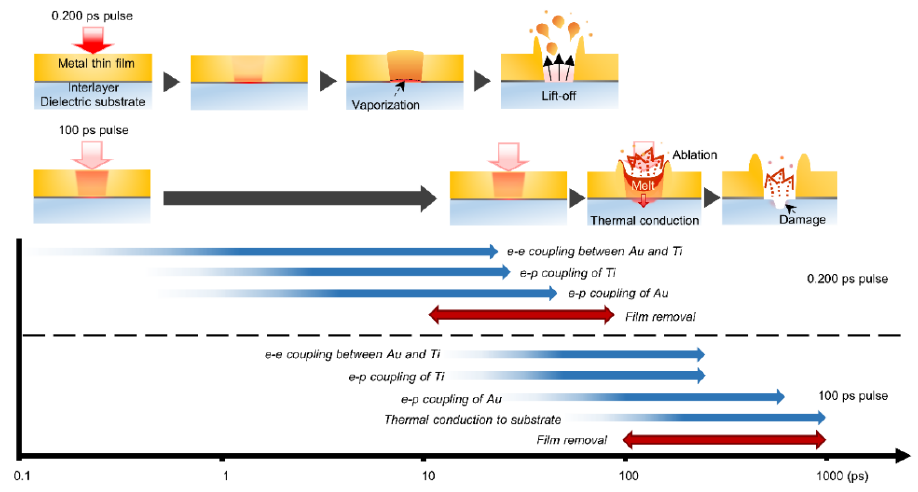
Figure 1. Schematic illustration of the ablation process of a thin metal film (Au) in the pulse duration range of 0.2–100 ps, reproduced from [17], with permission from Springer Nature, 2021.